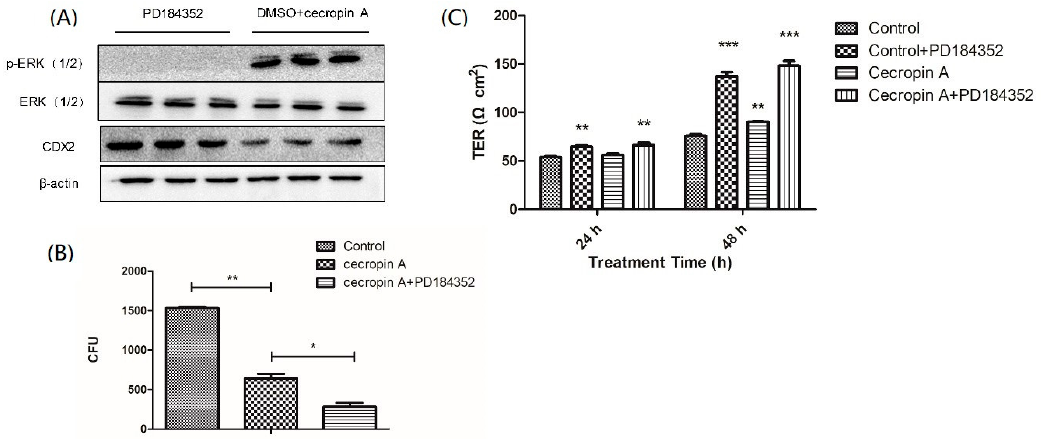
Figure 5. The effect of inhibiting ERK phosphorylation on TER and E. coli adherence. TER was upregulated (( B ), n = 3) through inhibition of ERK phosphorylation (( A ), n = 3). IPEC-J2 cells were treated with the ERK-specific inhibitor PD184352, cecropin A and cecropin A + PD184352 for 24 and 48 h, and the CFUs of adherent E. coli were decreased after the PD184352 treatment for 48 h ( n = 3). Data (mean ± SEM) were analyzed with the Student’s t -test ( A ) and one-way ANOVA ( B , C ). The results were confirmed by three independent experiments per treatment. Representative results of the three independent experiments are shown. * p < 0.05, ** p < 0.01, *** p < 0.001.